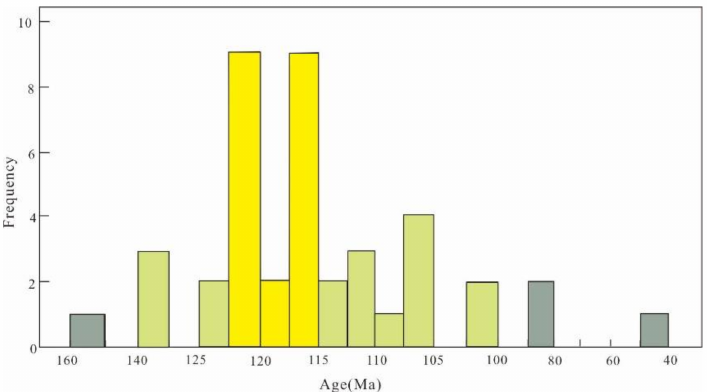
Figure 8. Metallogenetic age statistics of typical gold deposits in the Jiaodong area. (data from